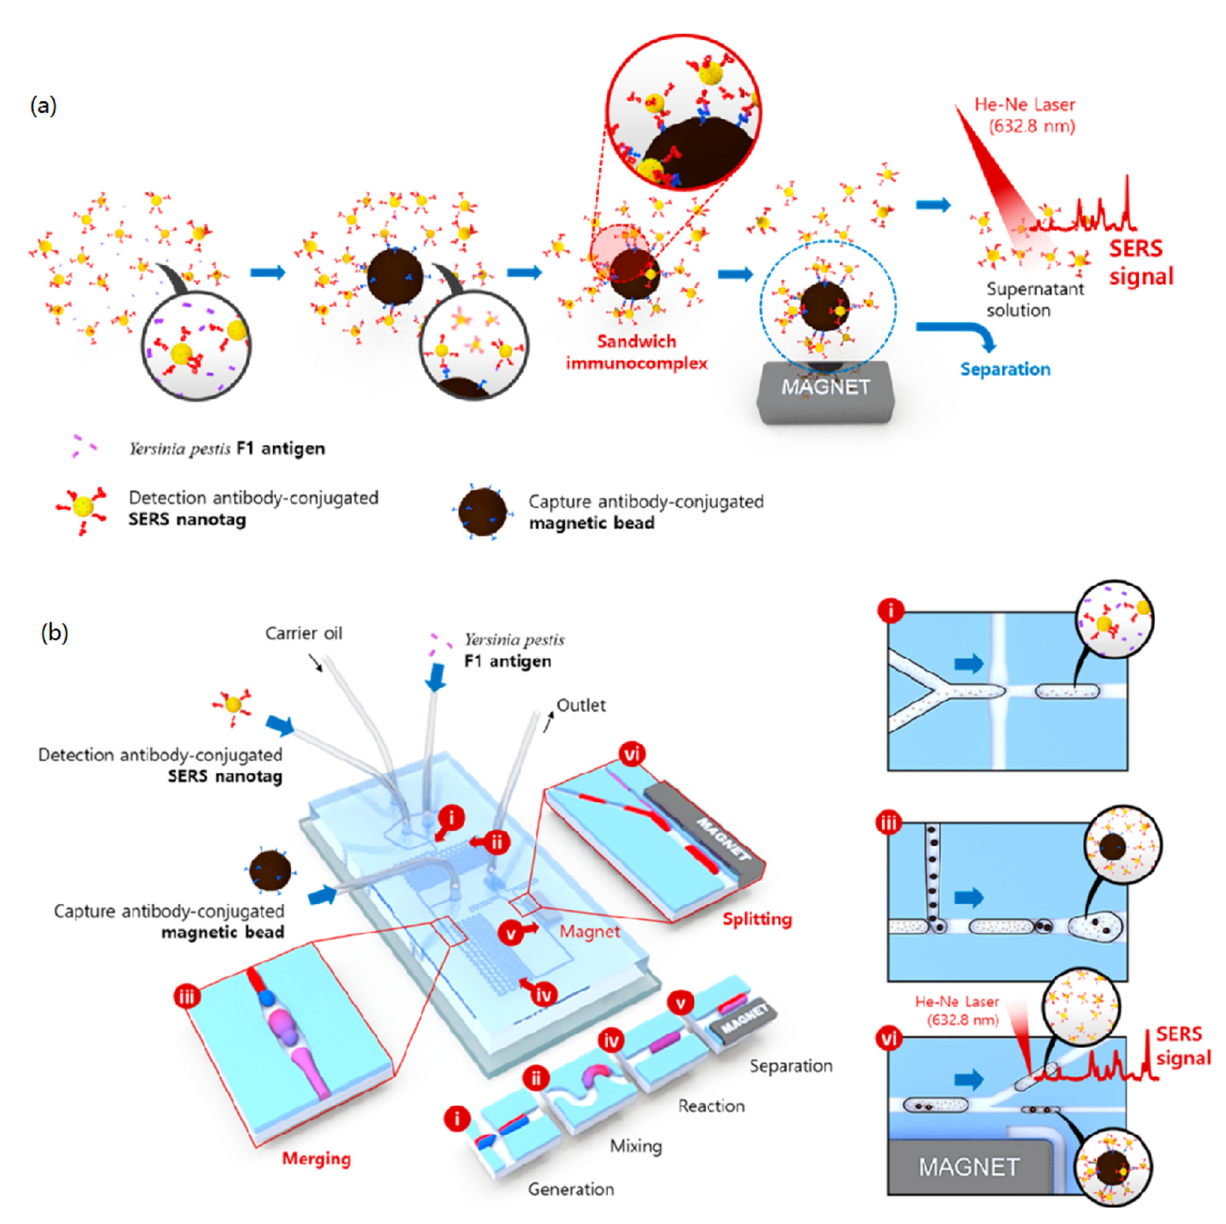
Figure 9. ( a ) Schematic diagram of F 1 antigen detection immunoassay platform based on SERS nano tag and magnetic beads. ( b ) Schematic design of the integrated SERS-based microfluidic channel composed of six microdroplet compartments. ( a , b ) Reproduced with permission of Ref. [84] , Copyright 2017, American Chemical Society.